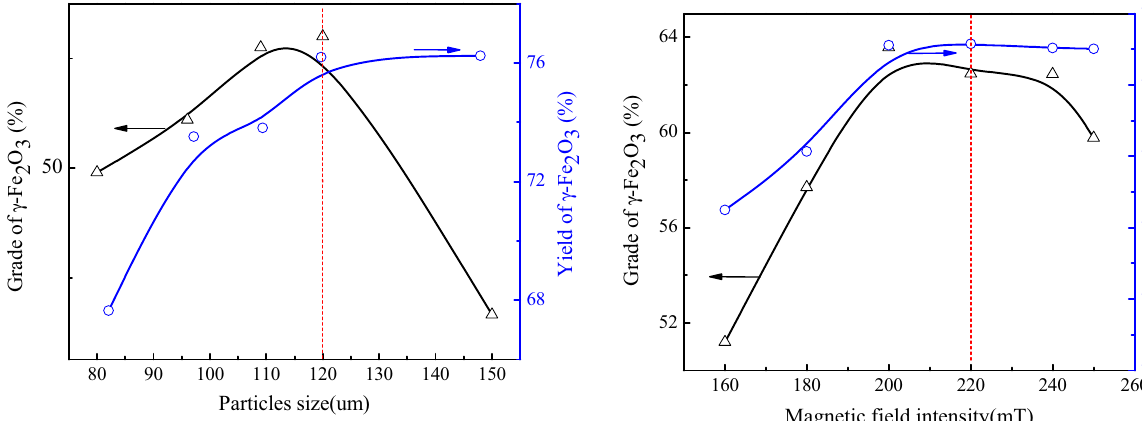
Figure 5: E ff ect of size of particles on γ - Fe 2 O 3